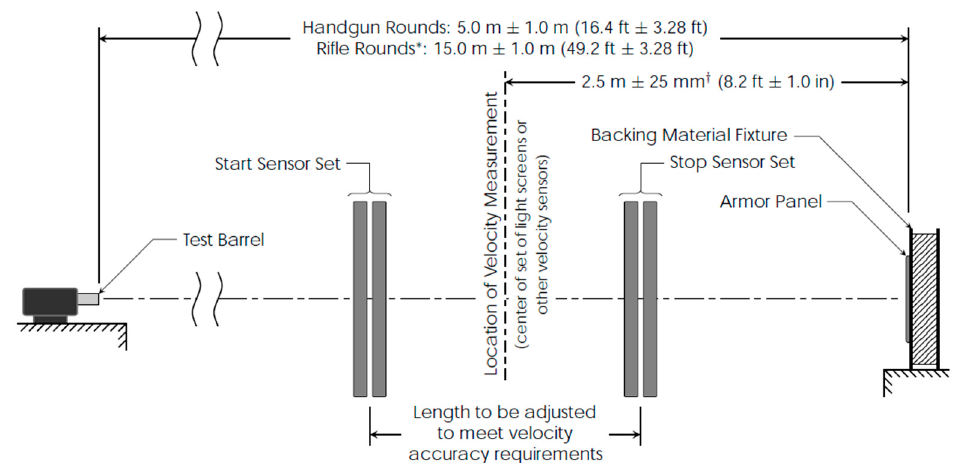
Figure 3. Firing arrangement equipment, Reprinted with permission from ref. [23], Copyright Year Copyright Owner’s Name. * For rife rounds the length may be further adjusted to minimize yaw at impact; however, in such cases the yaw at impact must be experimentally shown to be less than 5° and reasonably close to minimal. † Tolerance for 0° shots. For 30° and 45 ° shots the tolerance shall be +25 mm/ − 190 mm (+1.0 in/ − 7.5 in).